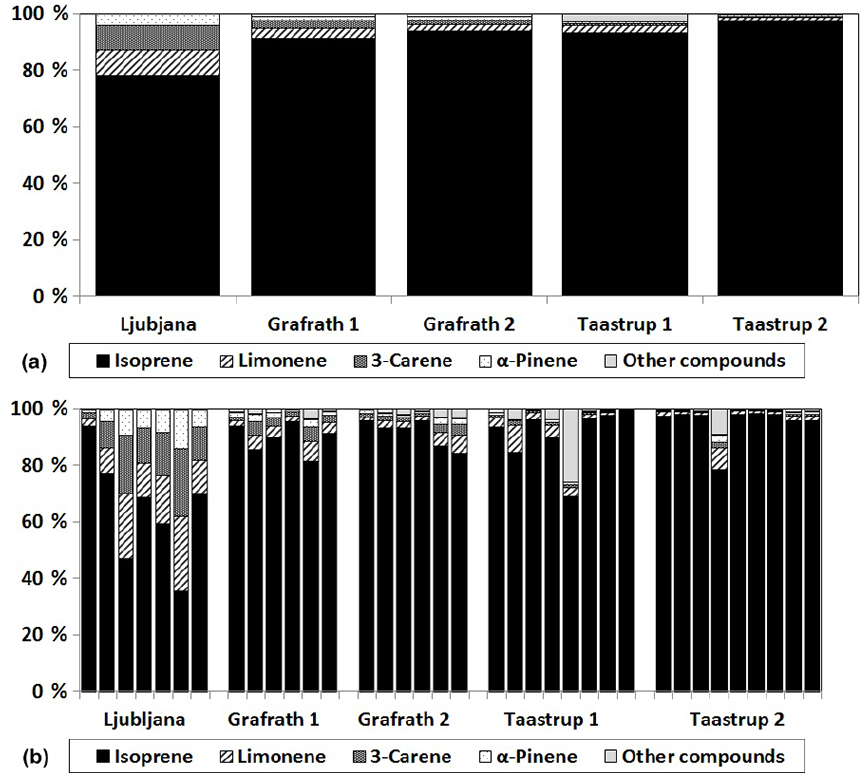
Figure 5. Relative BVOC compound contribution from English oak seen as (a) sample averages for different trees and sites and (b) for individual samples. The major emitted compounds are presented separately, whilst the remaining compounds are classified into other com-